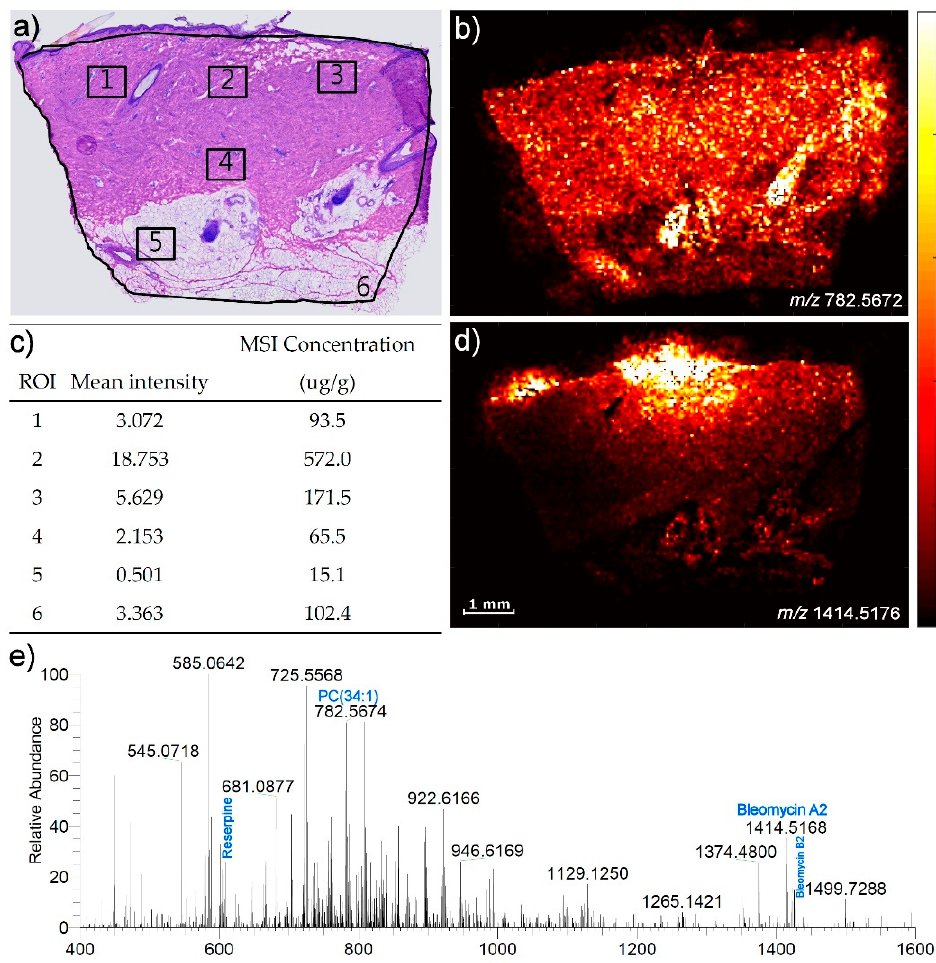
Figure 6. Quantitative MALDI imaging of a cross section of a skin biopsy from a pig, which was given an electropneumatic injection of bleomycin. ( a ) Microscope image of a neighboring H&E stained cryo-section. Squares mark the regions, which were later quantified. ( b ) MALDI-MS image of the endogenous lipid PC(34:1) ( m / z 782.5682). ( c ) Table with results of quantification of bleomycin in the regions of interest indicated in a). ( d ) Bleomycin A2 ( m/z 1414.51766), normalized to the signal of the internal standard reserpine. ( e ) Example of a mass spectrum extracted in ROI#4.